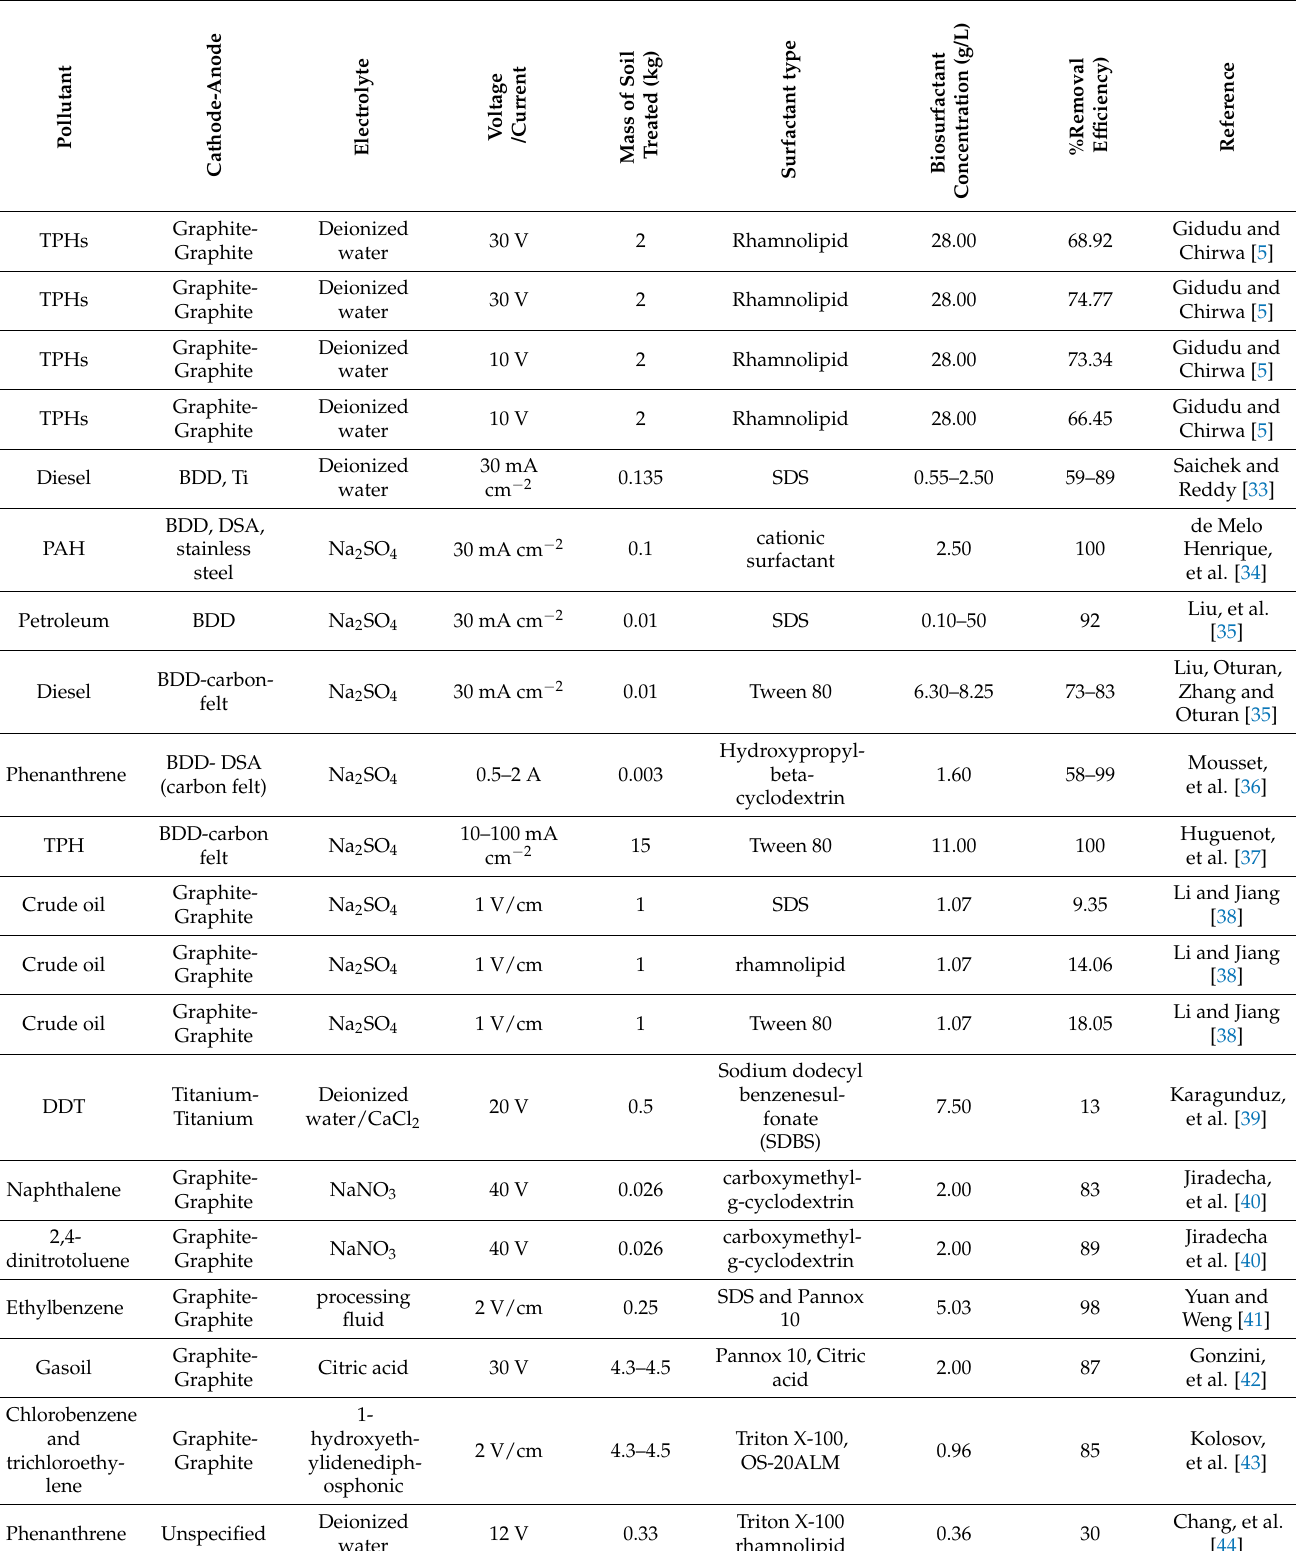
Table 1. Pollutants removed from soil by electrokinetic